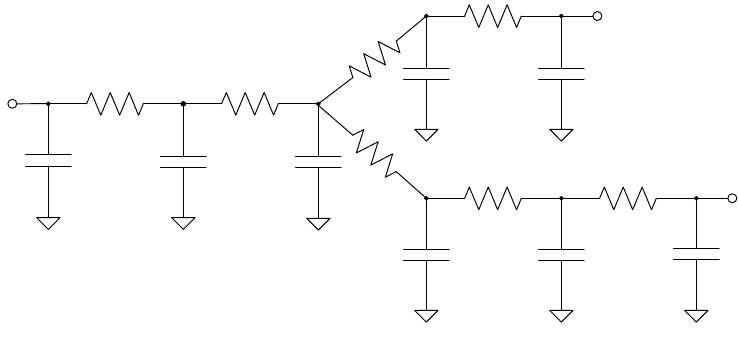
Figure 6. Distributed RC interconnection